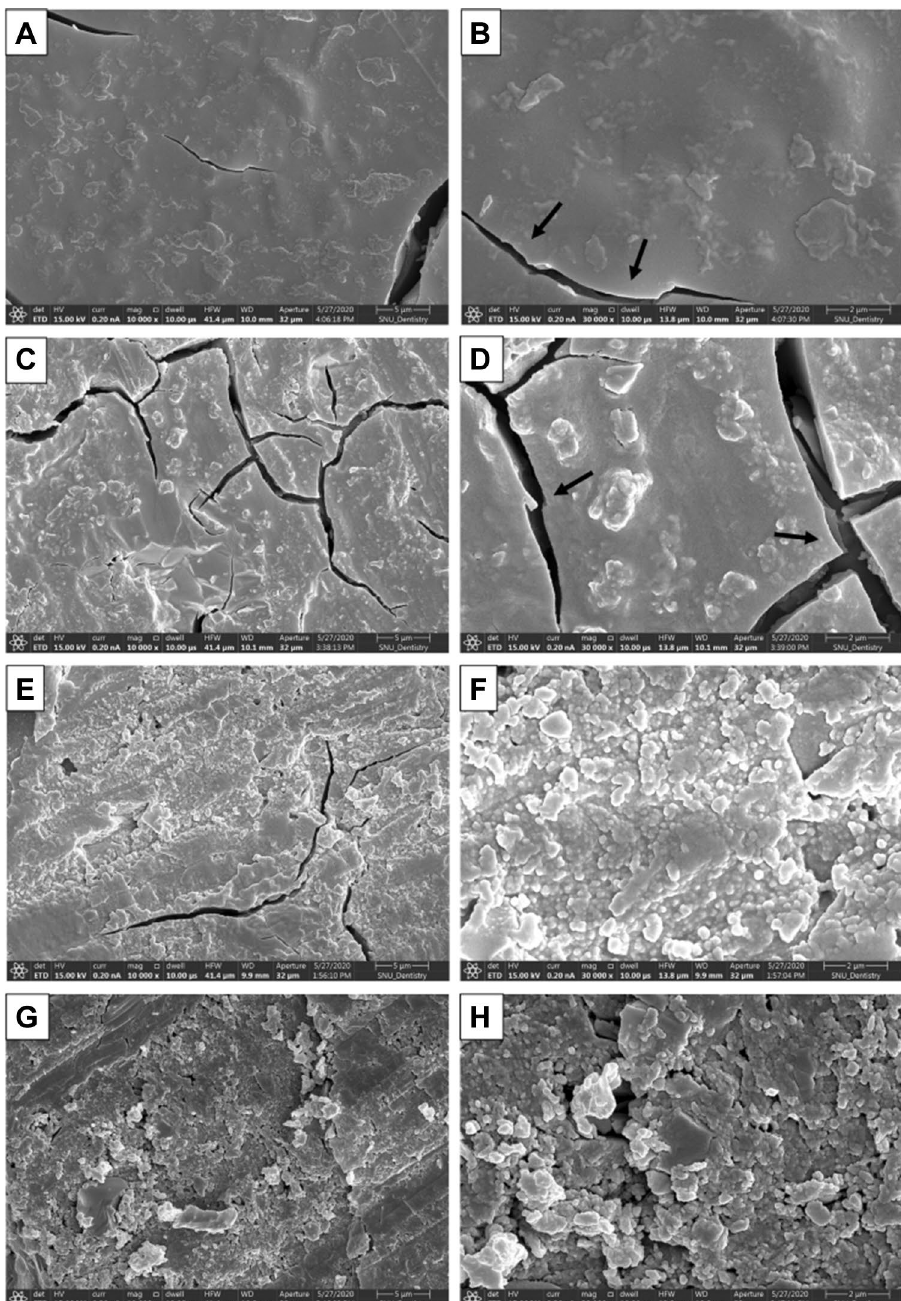
Figure 1. Representative FE–SEM images of GIC surface. ( A , B ) BG0 group; unreacted alumino-fluorosilicate glass is observed on the surface. Some crack lines are observed on the surface (black arrow). ( C , D ) BG5 group; some surface precipitates as well as crack lines (black arrow) are observed. ( E , F ) BG10 group; precipitates formed on the surface, covering the cracks. ( G , H ) BG20 group; the observed rough surface of GIC caused by an abundance of precipitate formation. The cracks are hardly observed owing to abundant crystal